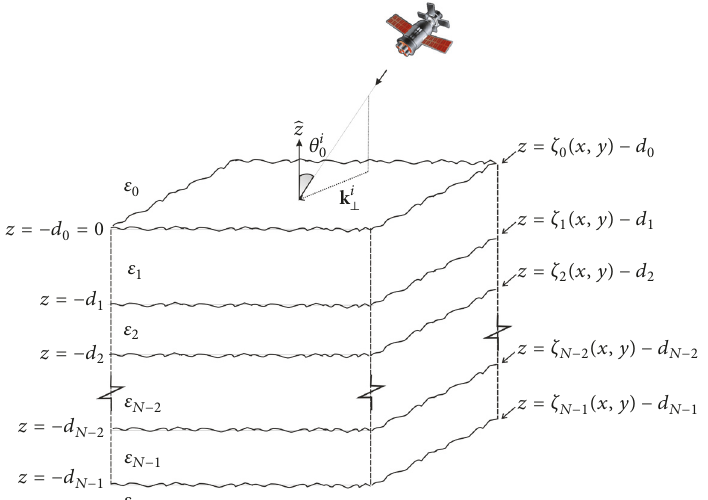
Figure 1: Schematic rough multilayer structure. The interfacial roughness of the 𝑖 th interface is described by the 2D random process 𝜁 𝑖 (𝑥,𝑦) .